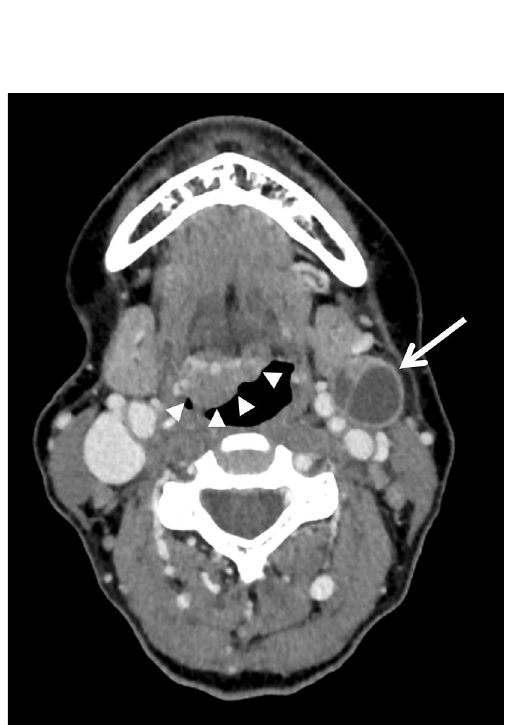
Figure 5. Axial CT slice showing a P16+ tumour of the base of tongue (arrowheads) and a typical cystic node without extra-nodal extension in the IIa left area (arrow) of a 53-year-old female with no history of tobacco or alcohol